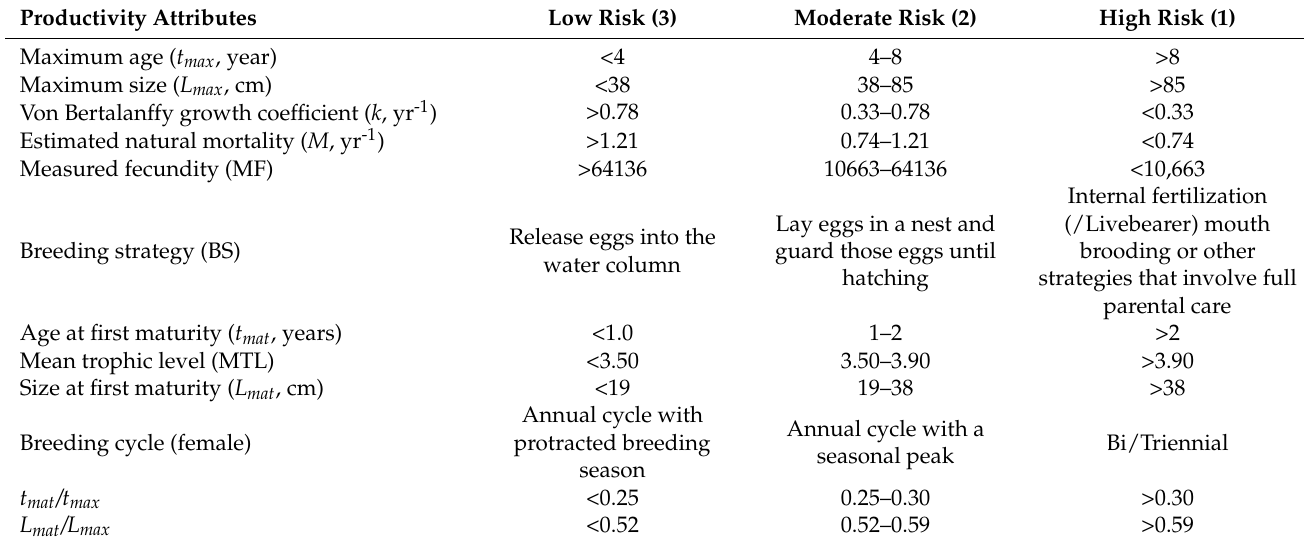
Table 2. Productivity attributes and their scoring criteria were used to determine the productivity of the selected bycatch stocks from the Hilsa gillnet fishery in Bangladesh (adopted from Faruque and Matsuda, 2020). Productivity